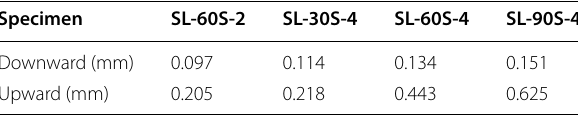
Table 5 Summary of displacement by